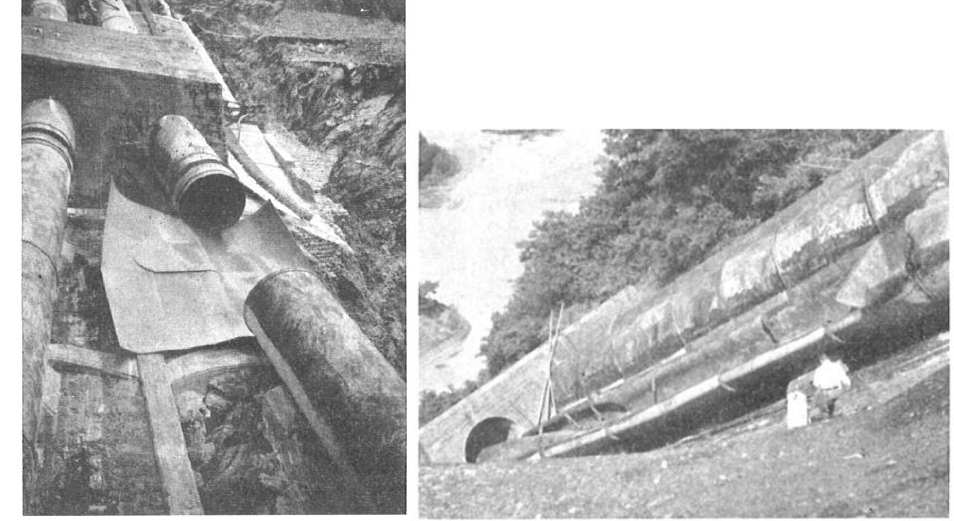
Figure 11. Penstock failure at Oigawa HPP in 1950 in Japan [93].